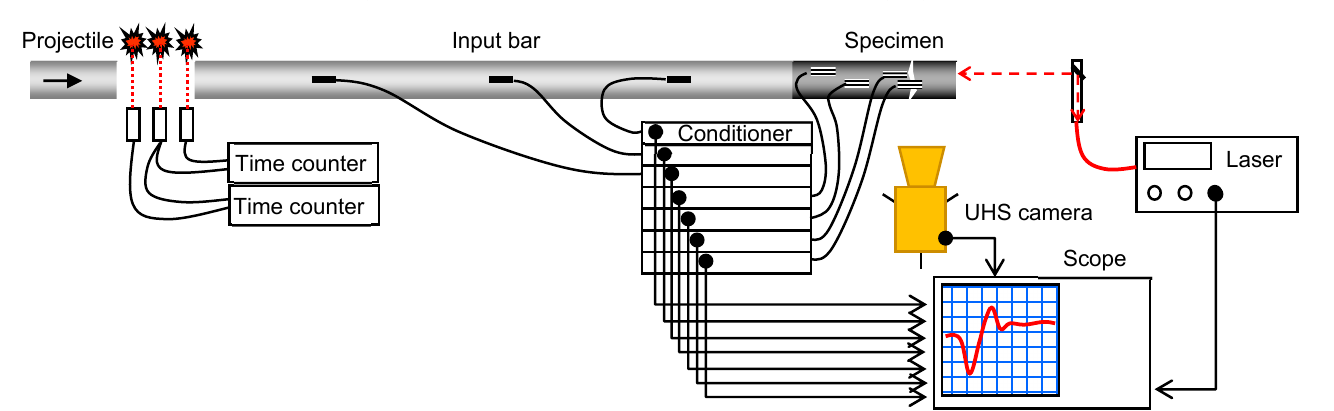
Figure 1. Apparatus used for spalling tests.